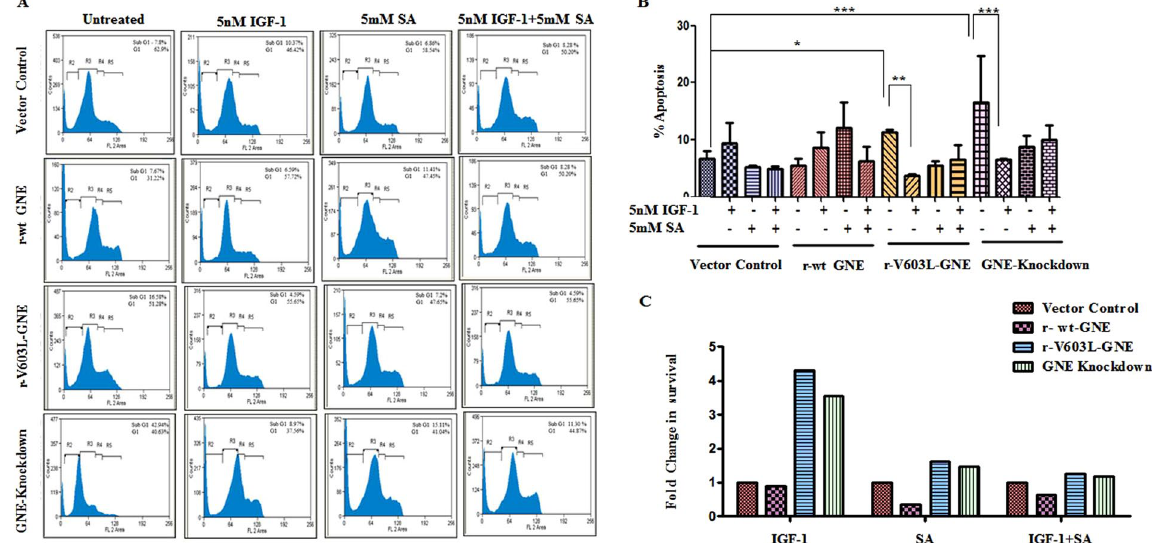
Figure 5. Cell cycle analysis of GNE deficient cells: The cell cycle analysis using propidium iodide was done by Flow Cytometry. ( A ) Representative histogram of the distribution of GNE deficient cells and GNE mutant cells in various phases of the cell cycle. Cells were treated with 5 nM IGF-1 alone, Sialic acid alone or a combination of both (IGF-1 + SA) ( B ) Graphical representation of cells in sub G0/G1 phase (% apoptosis).The statistical significance was assessed by One-way ANOVA test followed by Bonferroni post tests, P values for * , ** and *** are < 0.05, < 0.001 and < 0.0001, respectively. ( C ) Graphical representation showing fold change in cell survival which is calculated by taking the ratio of percentage sub G 0 /G 1 population cells (represented by R2 in histograms 5A) obtained from 5B of IGF-1 treated versus untreated, SA treated versus untreated and IGF-1 + SA treated versus untreated, normalized to vector